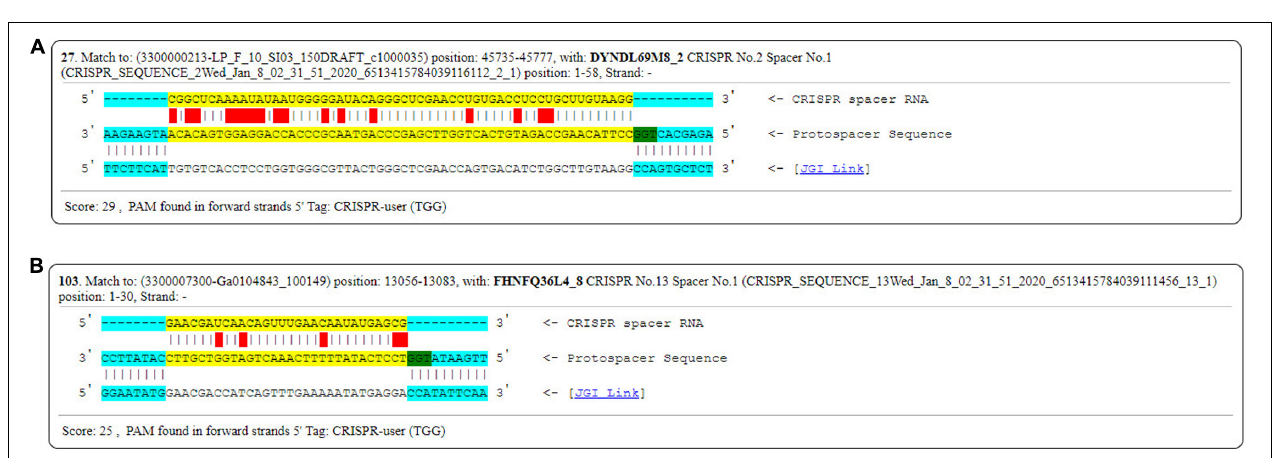
FIGURE 15 | PAMs sequences found in DYNDL69M8 and FHNFQ36L4. (A) PAMs sequences found in DYNDL69M8. (B) PAMs sequences found in